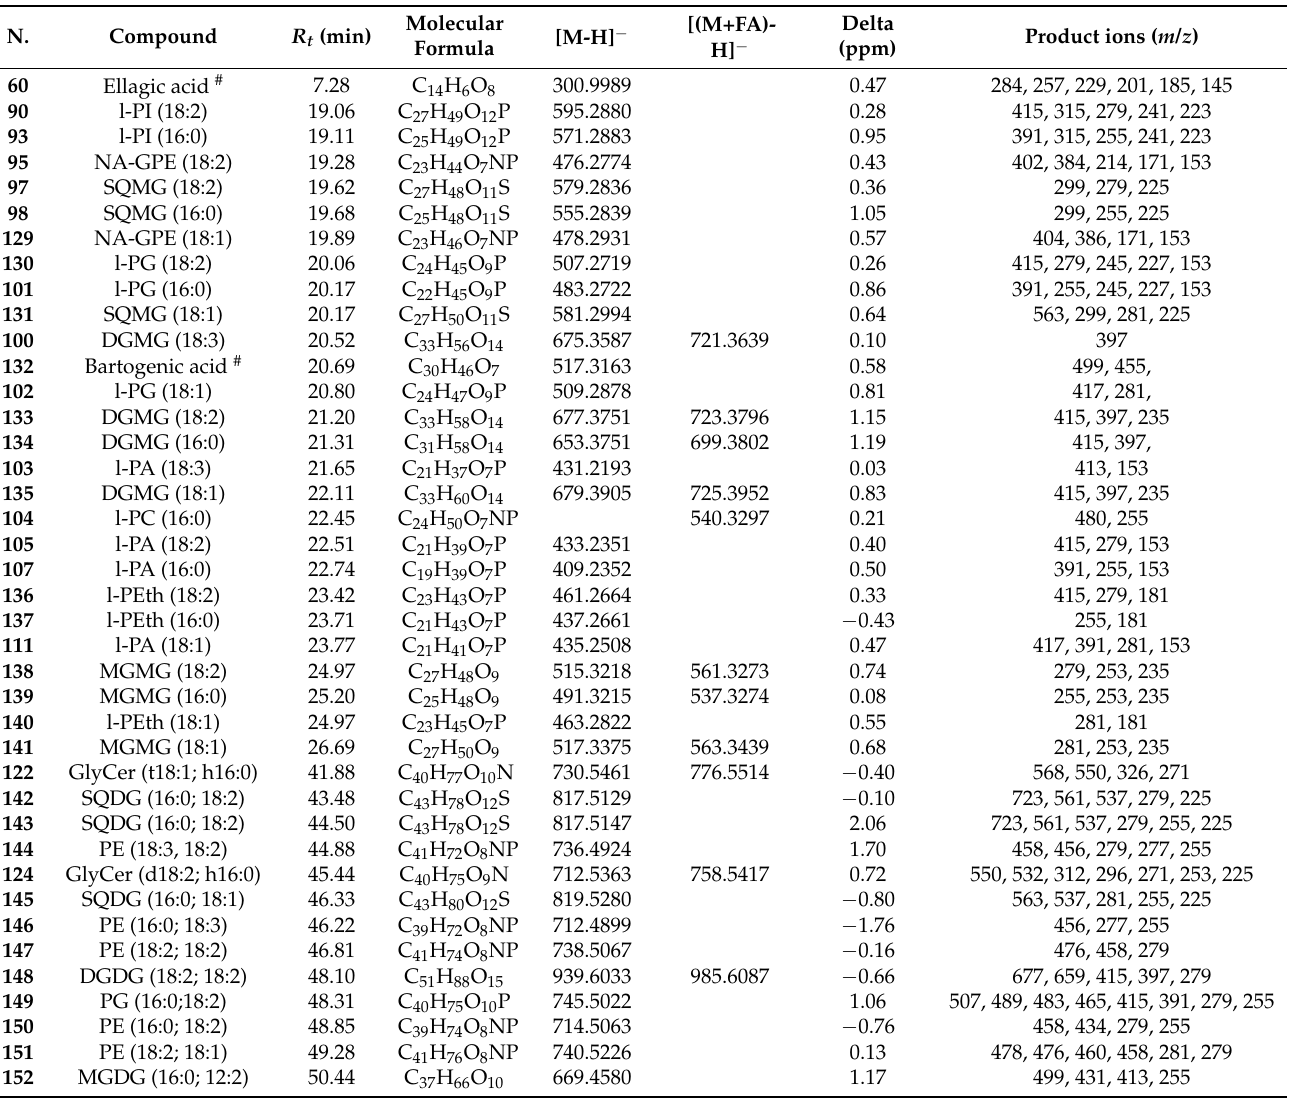
Table 4. Metabolites putatively identified in the MeOH extract of C. sativa (Marrone di Roccadaspide) chestnuts.